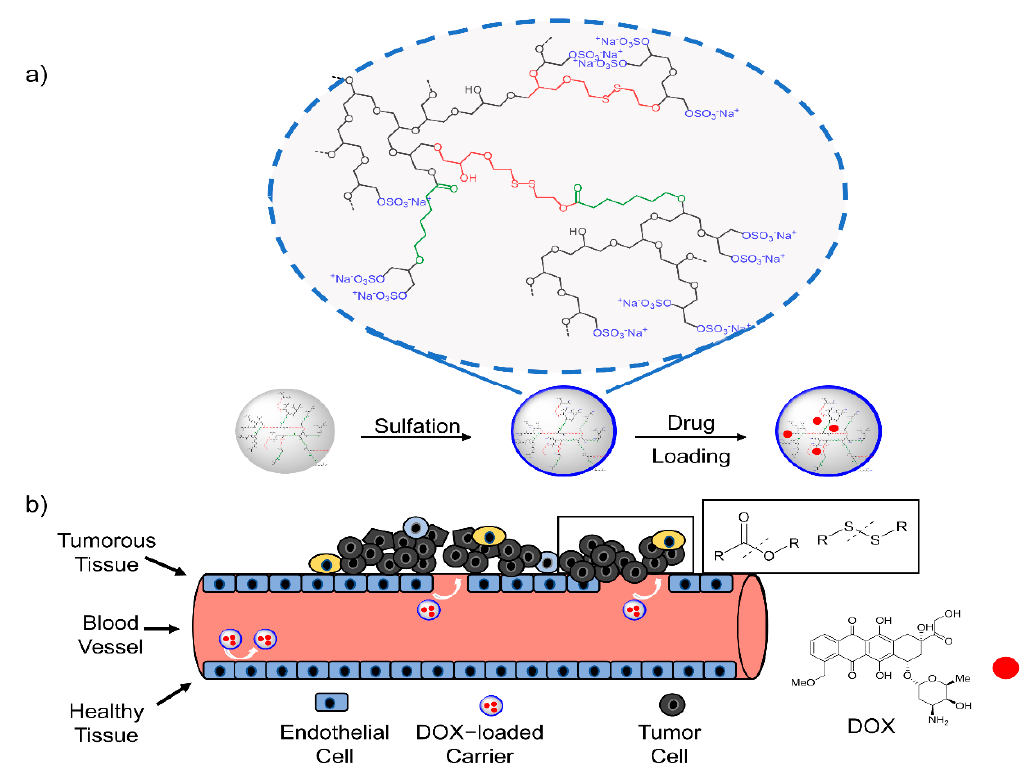
Figure 1. Schematic illustration of synthesis and DOX-loading of the polymeric DDS with subsequent drug release. ( a ) Synthesis of copolymer, sulfation and Dox-loading; ( b ) tumor targeting and underlying mechanism of drug release.